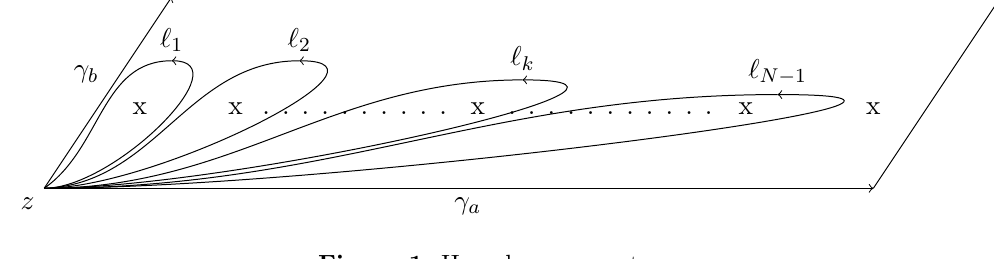
Figure 1 . Homology